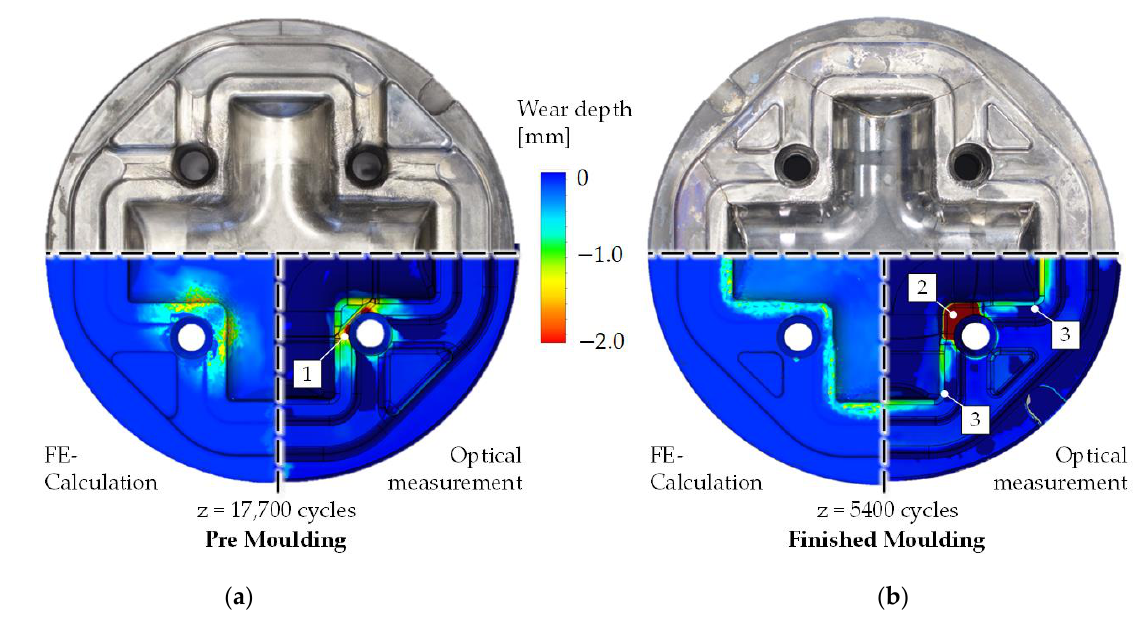
Figure 10. ( a ) Calibrated wear calculation of the premolding and ( b ) finished molding stage compared to optical measurements. Based on the results of the wear analysis, three findings (highlighted numbers